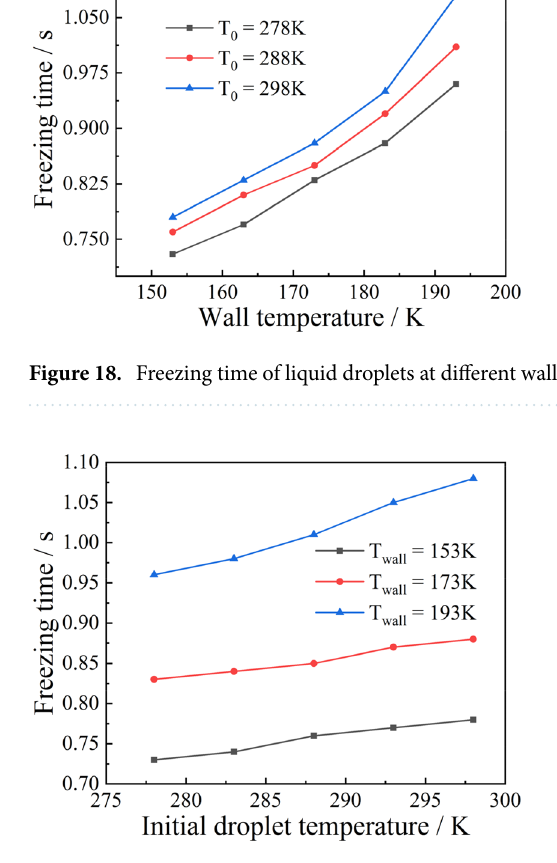
Figure 19. Freezing time of liquid droplets at different initial